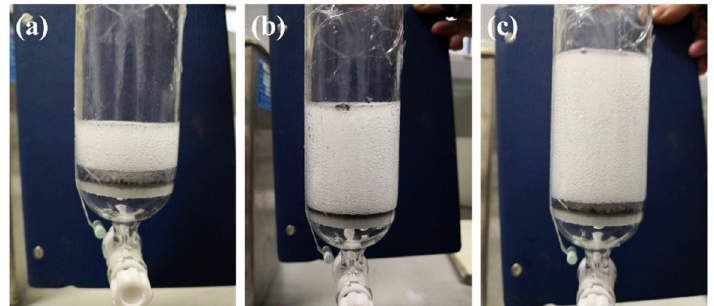
Figure 9. The foam structure of the solution in the presence of ( a ) KCl, ( b ) MgCl 2 , and ( c ) AlCl 3 at 0.10 mol/L.